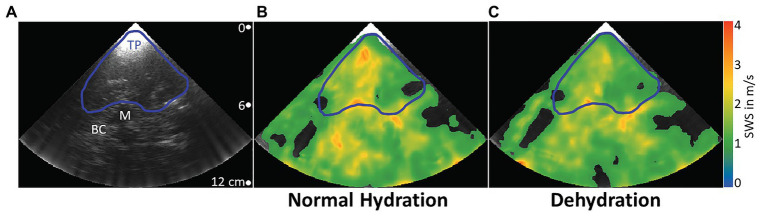
Representative B-mode image and elastograms in normal hydrated and dehydrated states. Transcranial B-mode image (A). Typical landmarks are the temporal parenchyma (blue line, TP), where ROIs were drawn, the mesencephalon (white line, M), which was used as the most prominent landmark, and basal cisterns (BC), a highly vascularized area around the mesencephalon with high echogenicity. Elastograms are shown as color-coded shear wave speed (SWS) maps. In the normally hydrated state (B), mean SWS in the demarcated region of interest is higher than in the dehydrated state (C).